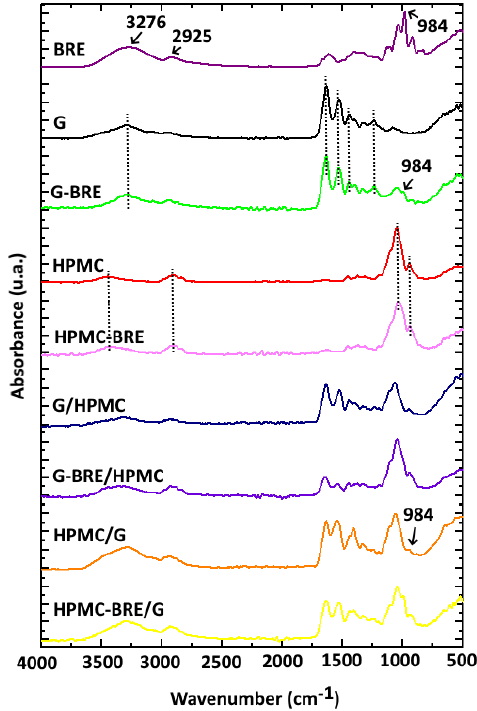
Figure 3. FTIR spectra of the uniaxial and coaxial core – shell capsules based on G, HPMC, and lyophilized beetroot extract, BRE.